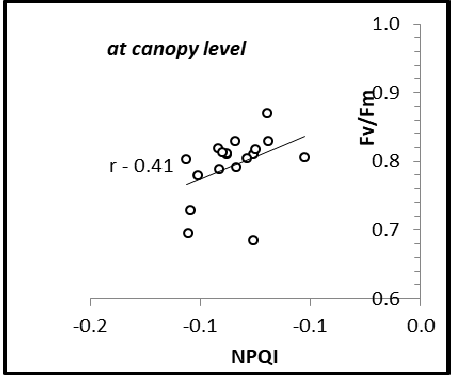
Figure-7 Fv/Fm vs NQPI